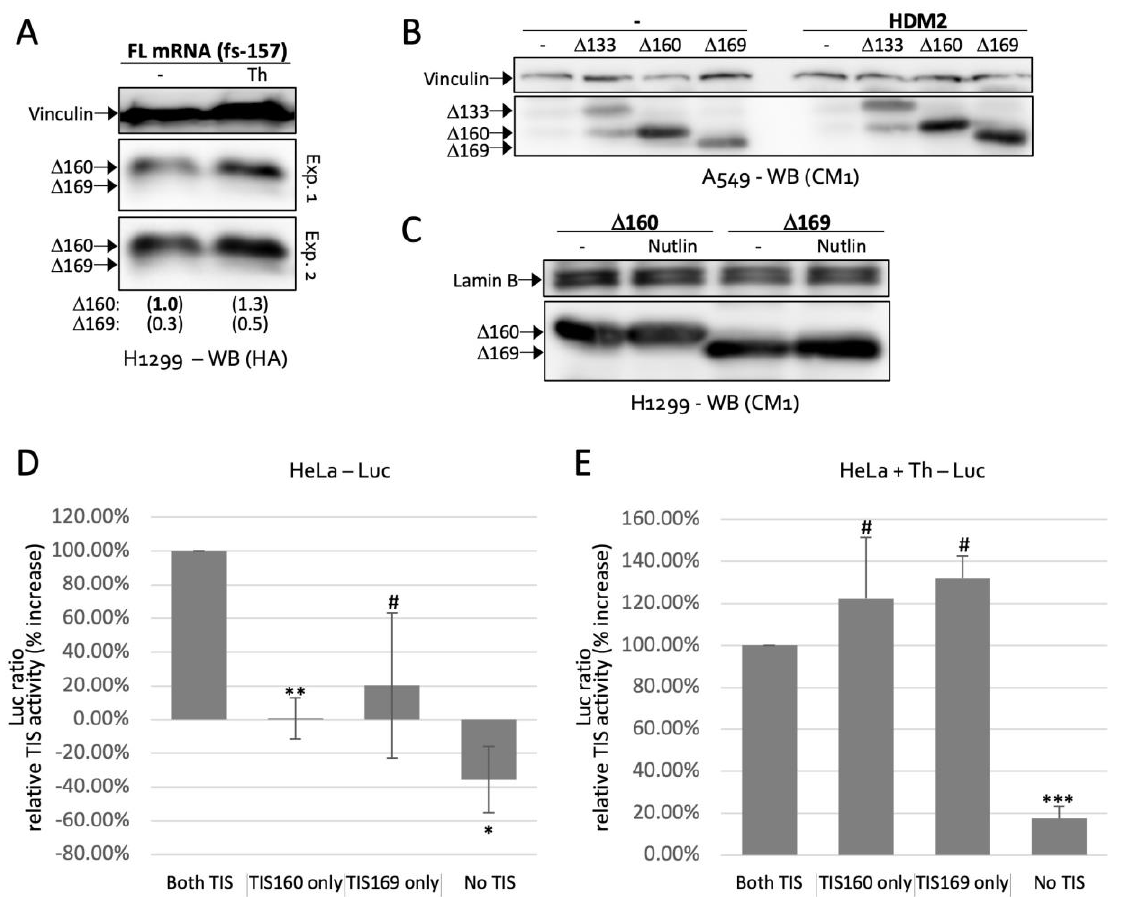
Figure 5. Stress enhances translation from individual translation initiation sites at codons 160 (TIS160) and 169 (TIS169): ( A – C ) Western blot analyses (WB) of H1299 or A549 cells expressing the indicated constructs and treated with DMSO ( − , 16 h), thapsigargin (Th, 16 h) or Nutlin-3 (Nutlin, 16 h). Values in brackets are quantifications of Δ 160p53 and Δ 169p53 presented as fold-change relative to Δ 160 + DMSO levels and normalized to vinculin ( A ). Exp. 1 and 2 indicate different exposure times ( A ). HA, anti-HA tag antibody; CM1, polyclonal anti-p53 antibody. ( D , E ) Luminescence readings (normalized % increase in Firefly Luciferase/Renilla Luciferase ratio over empty control) of HeLa cells expressing dual-luciferase mRNAs containing the first 432 nucleotides of ∆ 160p53 and no mutation (Both TIS), a mutation in TIS169 (TIS160 only), a mutation in TIS160 (TIS169 only) or both of these mutations (No TIS) and treated with DMSO ( D ) or Th ( E ). Shown are averages ± s.d. of 4 experiments (# p > 0.05, * p < 0.05, ** p < 0.01 and *** p < 0.005 compared to “both TIS”